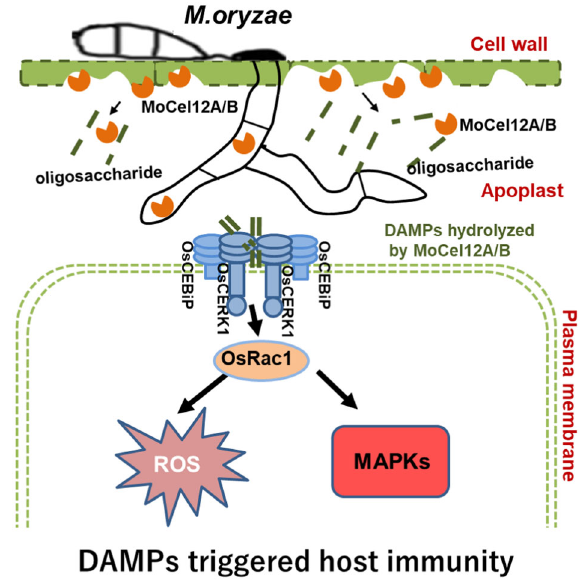
Fig. 6 The working model. During infection, M. oryzae secretes the endoglucanase MoCel12A and MoCel12B, which target rice cell wall hemicellulose for degradation. However, the oligosaccharides produced by MoCel12A and MoCel12B are perceived by immune protein complex OsCERK1-OsCEBiP, which transduces the signal to downstream OsRac1 for immune